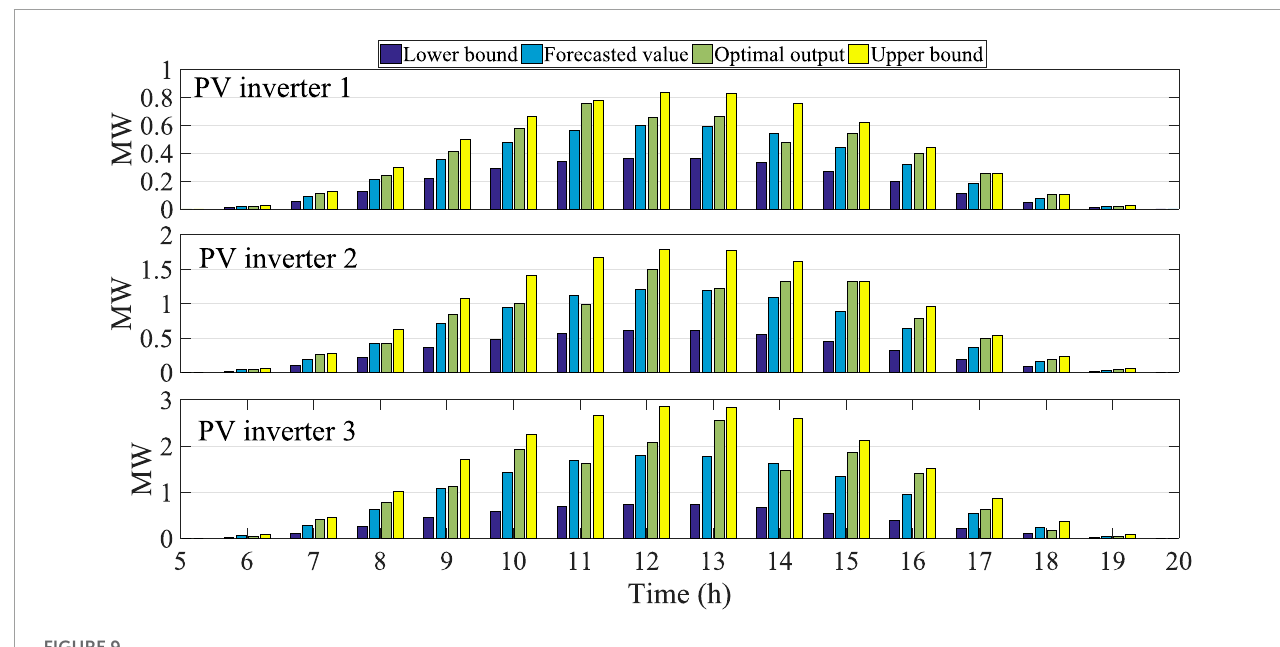
FIGURE 9 The optimal output, forecasted value, and lower and upper bound of PV inverter over